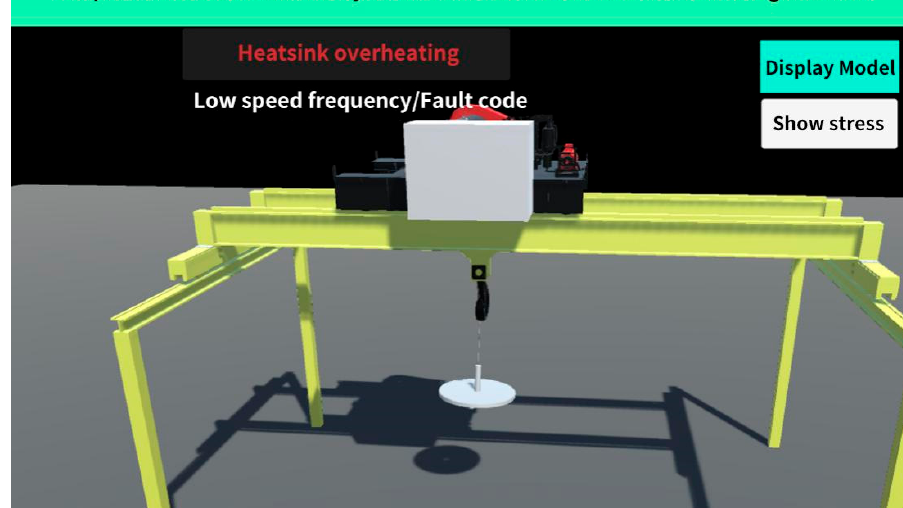
Figure 6. The prompt e ff ect of an abnormal